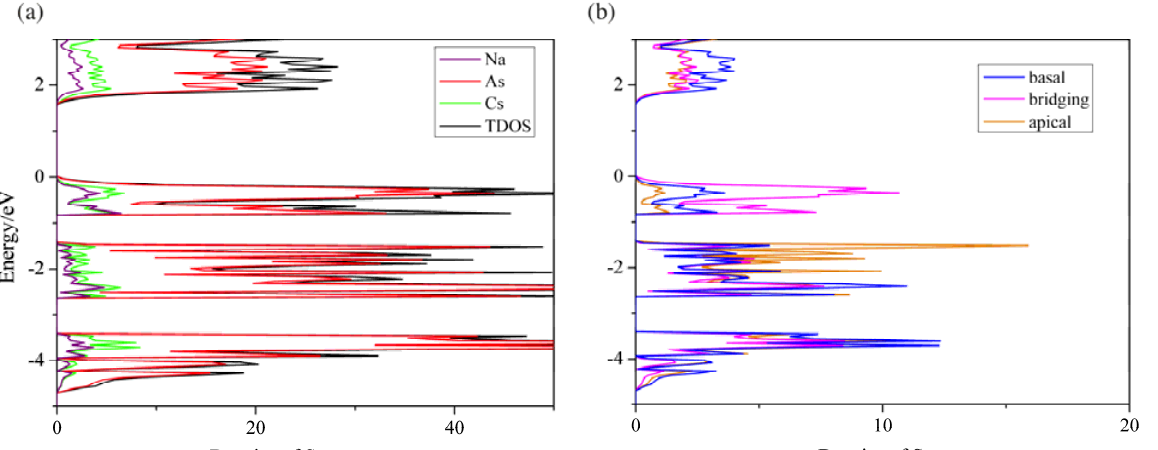
Figure 4. (a) Total and partial density of states (DOS) for Cs the average DOS of the different As atoms (see text for